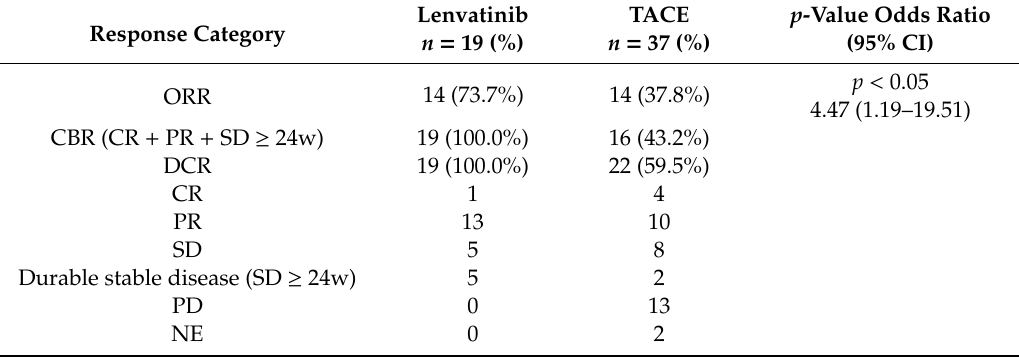
Figure A3. Overall survival (OS) in both groups with ALBI grade 1 after propensity score matching. OS in the lenvatinib-treated group was significantly better than that in the TACE-treated group (not reached (NR) vs. 23.1 months; HR 0.27, p = 0.021). NR; not reached. Table A1. Objective response rate in both groups with ALBI grade 1 liver